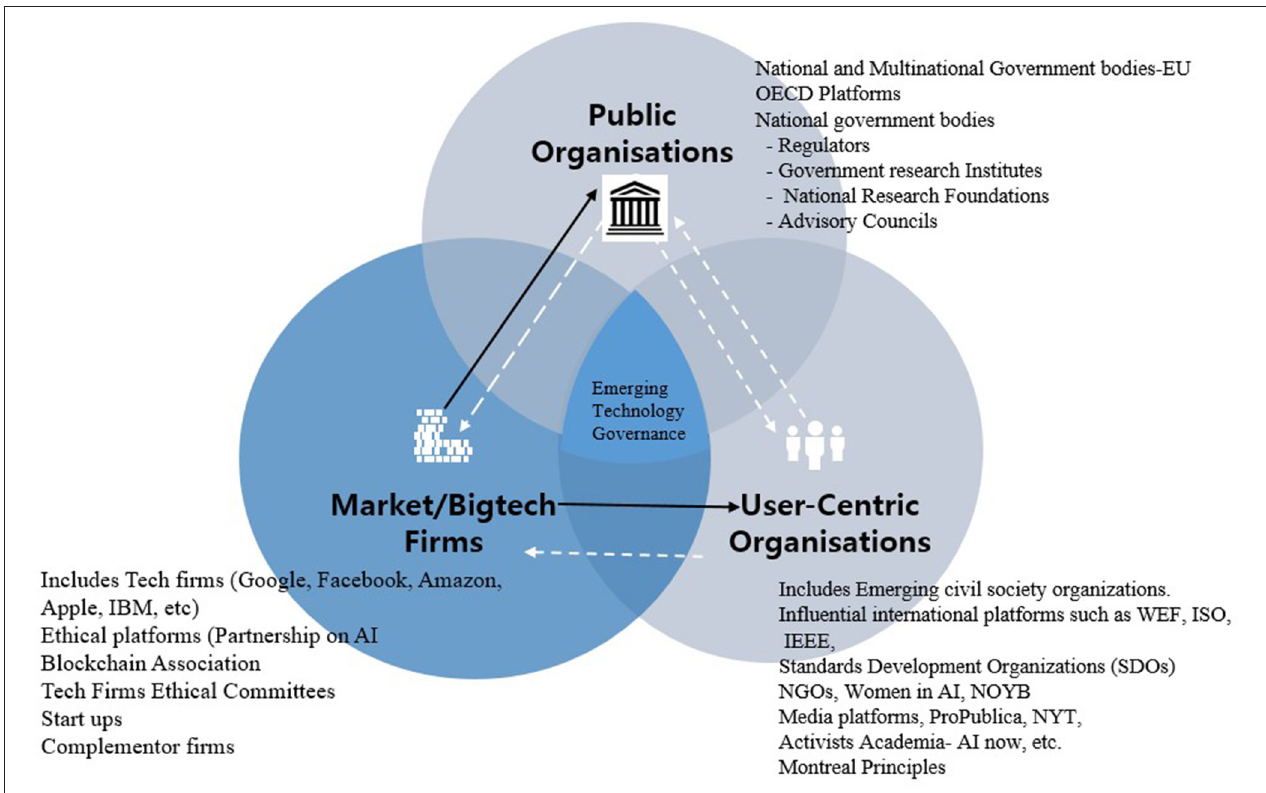
FIGURE 2 | Technology governance centered in the